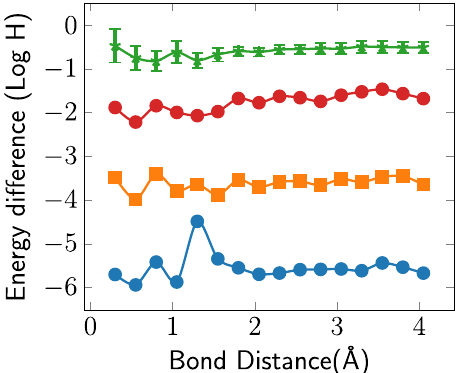
Fig. 6 Effect of imprecise control parameters. Energy error for the dissociation of H 2 is shown. Instead of using the exact, optimized parameters, we use parameters which have added Gaussian noise uncertainty. For each optimal parameter, we randomly sample 100 points each from a Gaussian distribution centered on its optimal setting and with a standard deviation of σ = {10 − 4 , 10 − 3 , 10 − 2 , 10 − 1 } which correspond to the blue, orange, red and green curves respectively. The resulting energies for these 100 trials are then averaged. Error bars are given for each point but are smaller than some markers.